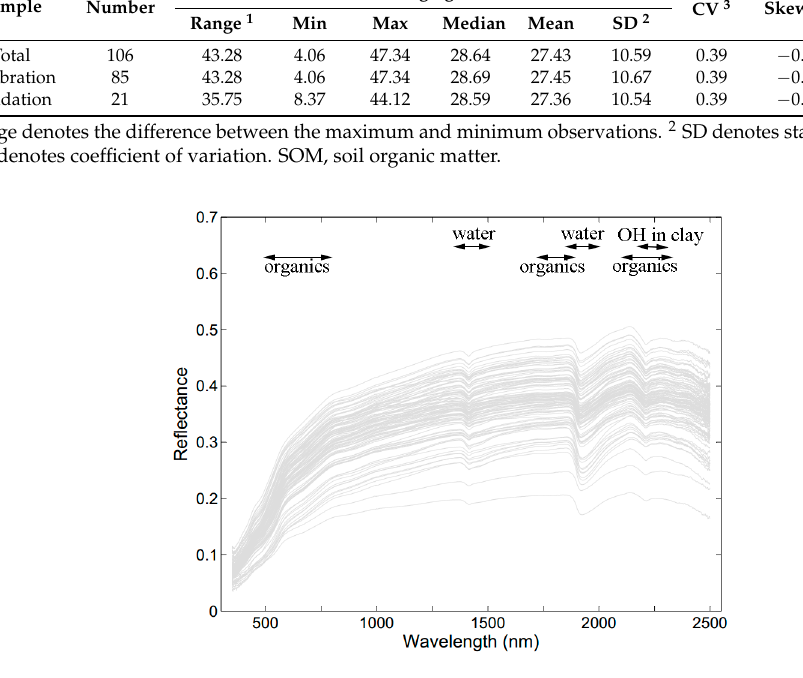
Table 1. Descriptive statistics of 106 soil samples for the calibration and validation sets.